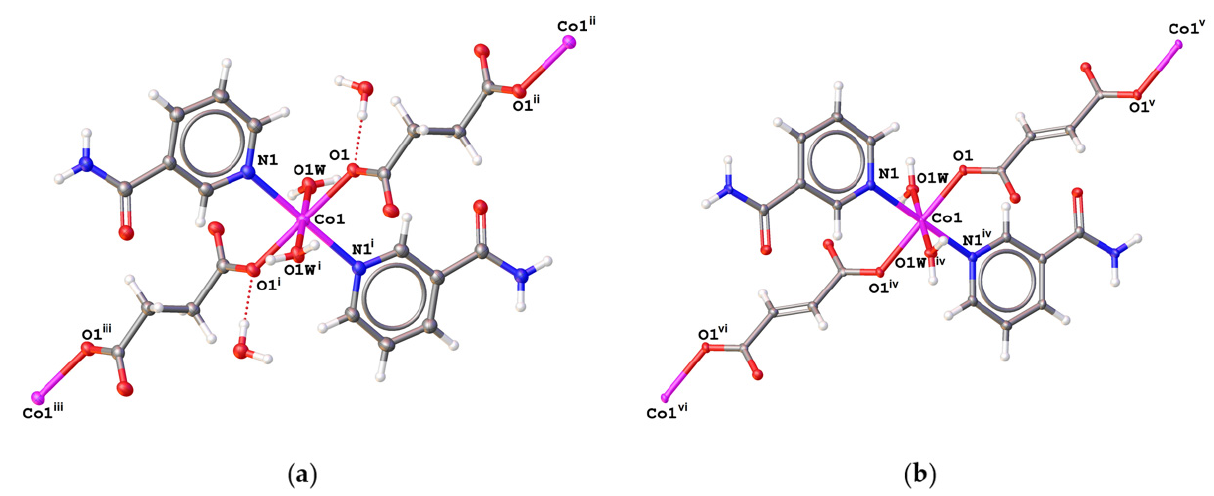
Figure 1. Comparison of perspective view of the molecular structure of the complexes: ( a ) I and ( b ) II . Thermal ellipsoids are drawn at the 50% probability level. Symmetry codes: (i) 1 − x , 1 − y , 2 − z ; (ii) − x , 2 − y , 2 − z ; (iii) 1 + x , − 1 + y , + z ; (iv) 1 − x , 1 − y , − z ; (v) − x , − y , − z ; (vi) 1 + x , 1 + y , + z .